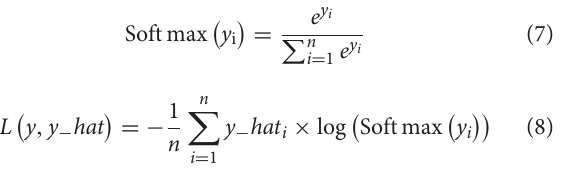
signals are not all index data, and cannot be used to indicate a certain physiological state just because the value of which reach a specific threshold. Therefore, the input of multi-dimensional time period data is needed to ensure the introduction of continuous characteristics of signals, so as to make the model more robust and practical (Jia et al.,